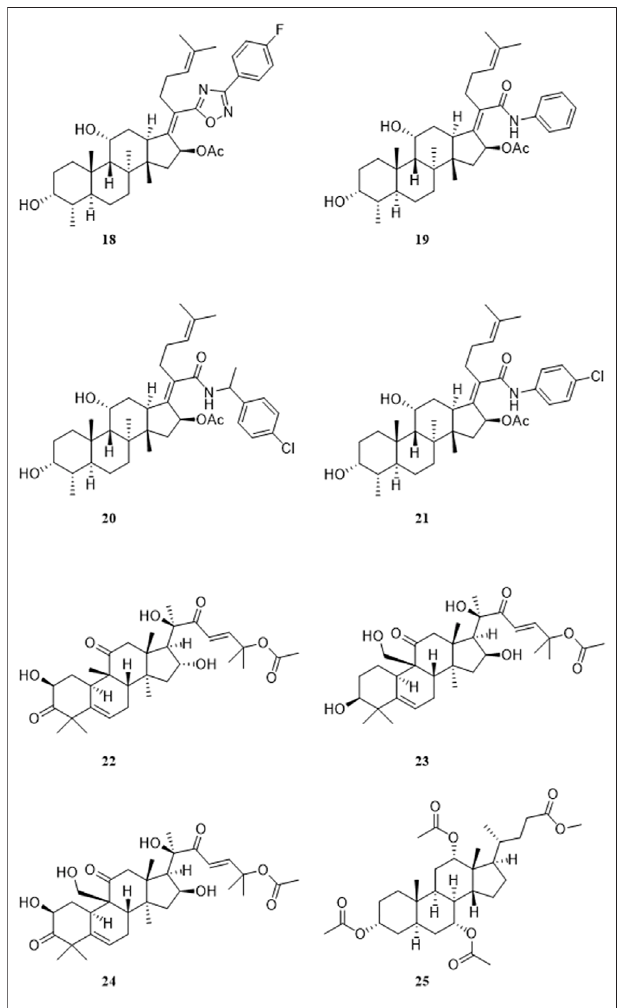
FIGURE 6 | Structural formulas of compounds 18 – 25